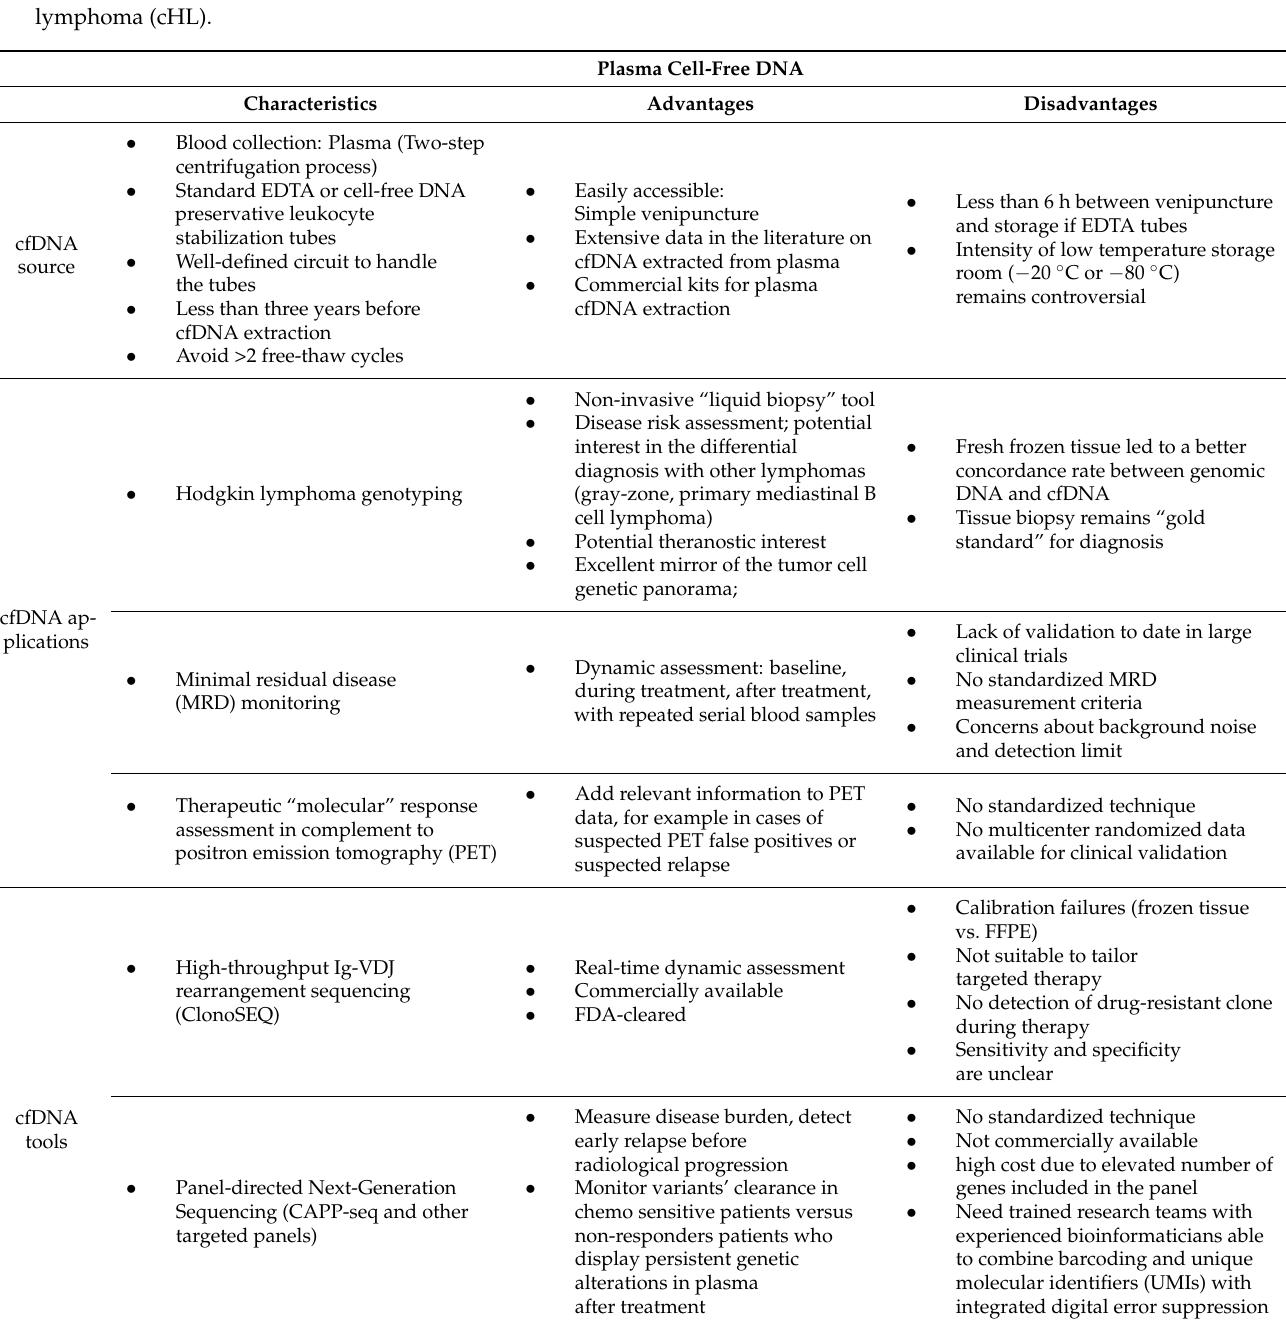
Table 1. Minimal residual disease (MRD) assessment and “liquid biopsy” methods in patients with classical Hodgkin lymphoma